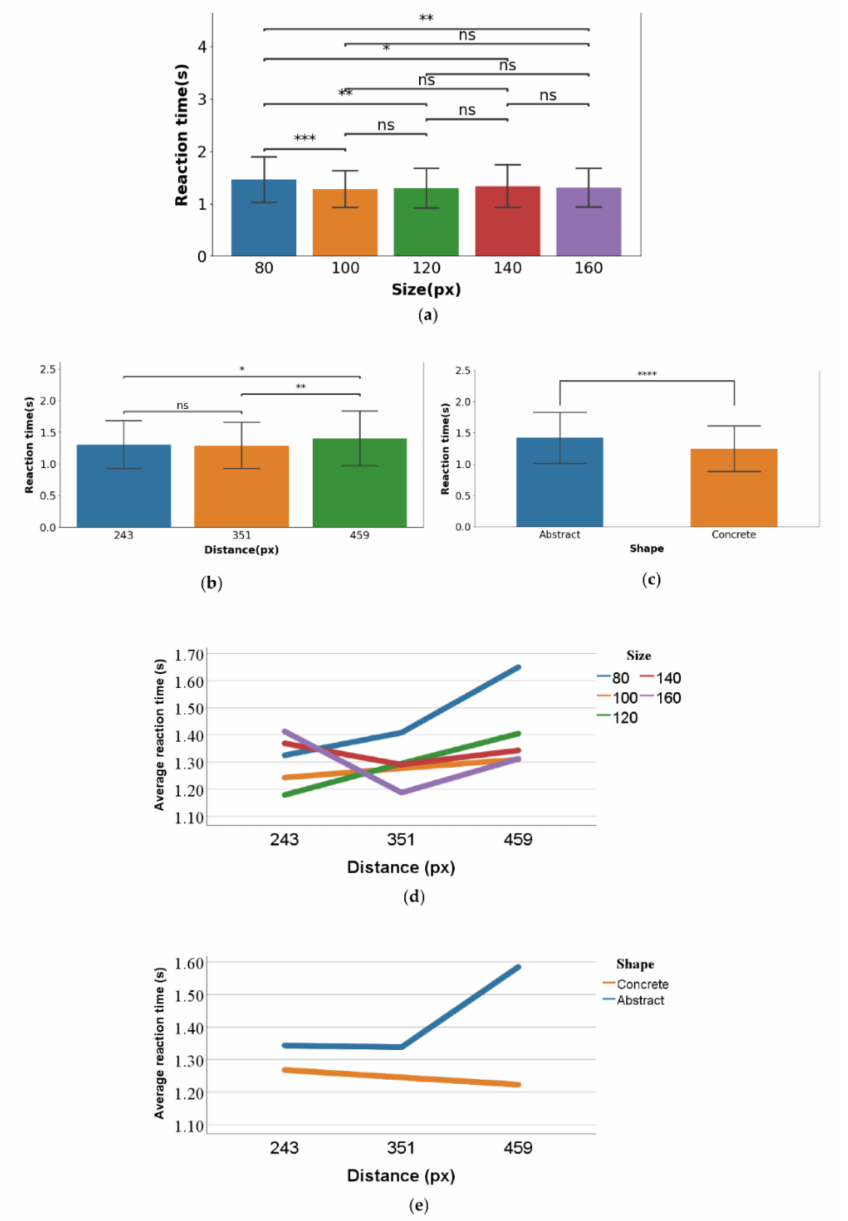
Figure 11. ( a – c ) Bar graphs of response times and post hoc multiple comparisons of main effect levels for the size, distance, and shape factors, respectively. The line between the levels indicates the results of the t-test at the level of the two variables, ‘ns’ indicates that no significant differences are presented between samples, ‘*’ indicates that significant differences are presented between samples, and ‘**, *** and ****’ indicates a higher significance. ( d , e ) show the simple effect analysis of interaction effect of distance × size and distance × shape,